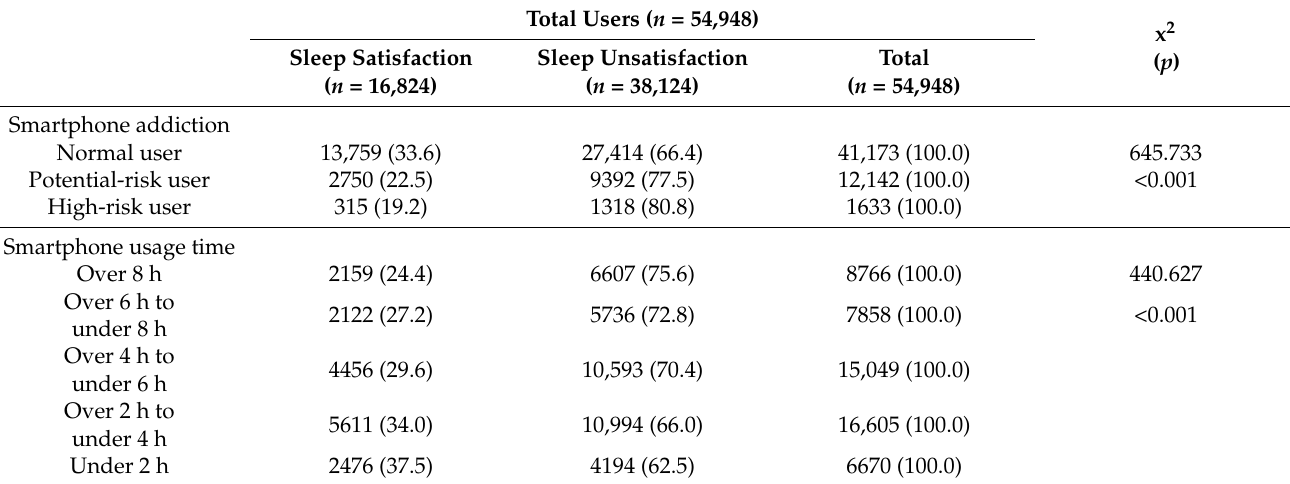
Table 3. Differences in smartphone addiction and daily average smartphone usage time according to sleep